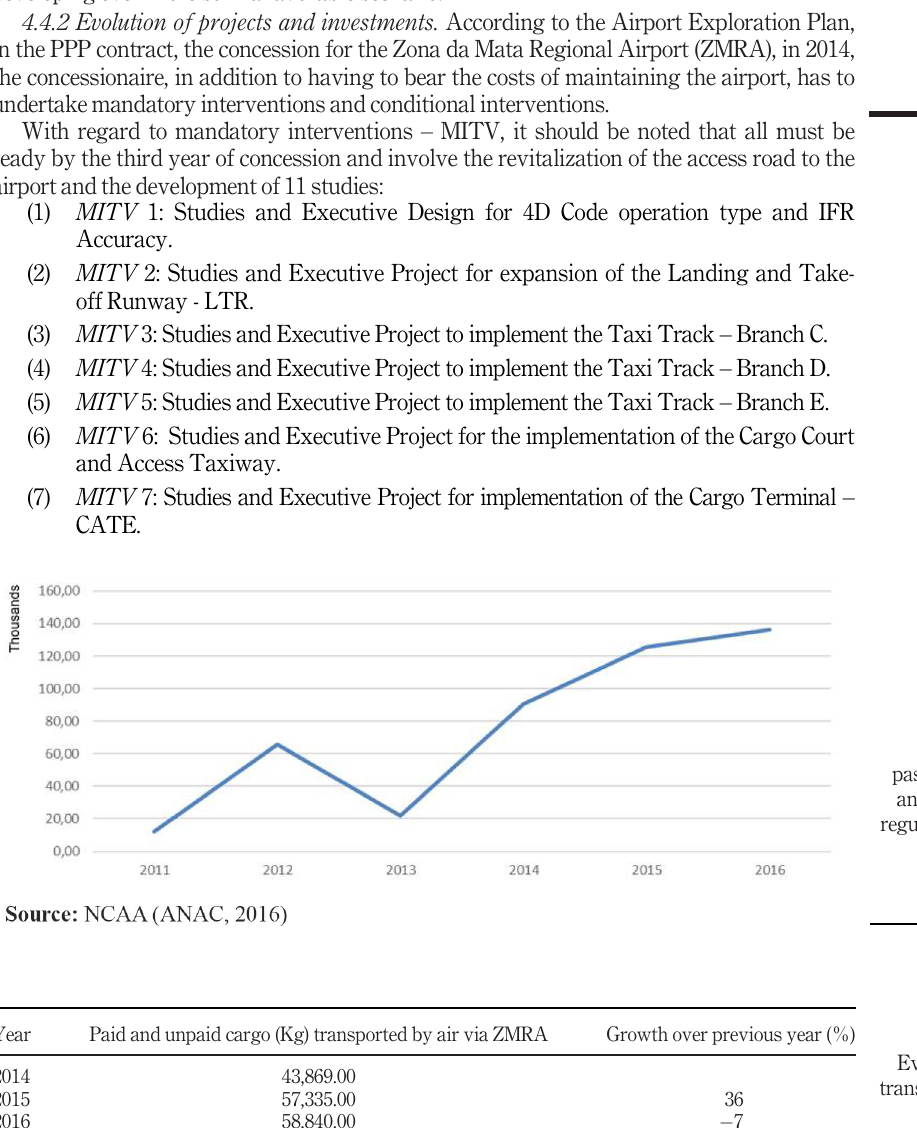
Table II. Evolution of cargo transport in kg (paid and unpaid) transported from